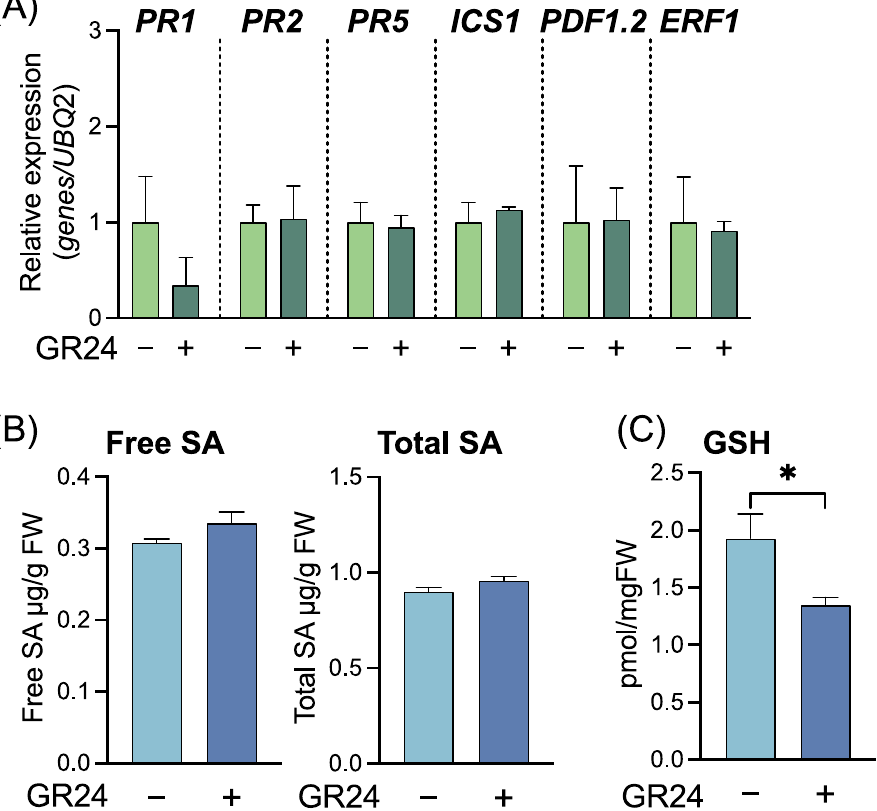
Figure 5. Analysis of defense-related gene expression and metabolite accumulation in Arabidopsis thaliana treated with GR24. Three-week-old plants were treated with 0.02% acetone (control) (–) or 10 µM GR24 (+) using the soil drenching method, and leaves were collected 3 d after treatment. ( A ) Expression levels of PR1 , PR2 , PR5 , ICS1 , PDF1.2 , and ERF1 in GR24-treated plants. Transcript levels were normalized using the expression of UBQ2 in the same samples. Relative mRNA levels of each gene among the treatments are presented. Values are means ± SE ( n = 4). ( B , C ) Accumulation of free and total SA and GSH in GR24-treated plants. The levels of free and total SA (free SA + SA glucoside) and GSH were quantified using high-performance liquid chromatography. Significant differences between control and GR24-treated plants are indicated by * (unpaired t -test, p <